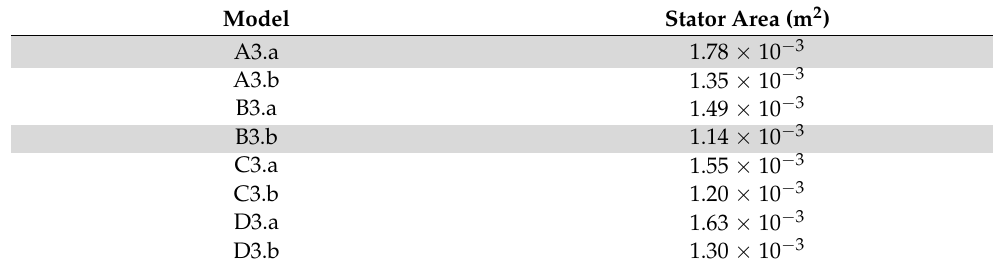
Table 2. Comparison of the stators area.